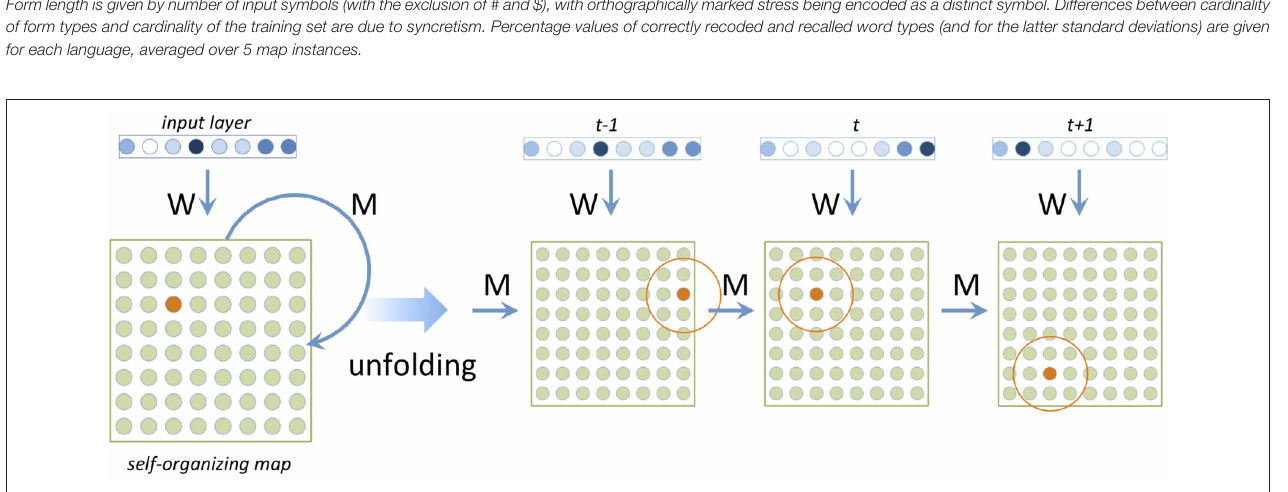
right, on the other hand, branching paths converge to the same node as soon as input forms share an identical symbol.